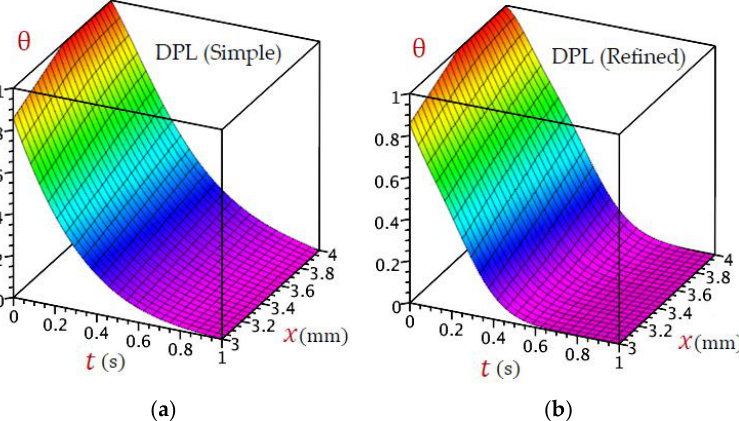
Figure 16. Three-dimensional distributions of temperature ( θ ) for ( a ) simple DPL and ( b ) refined DPL models.